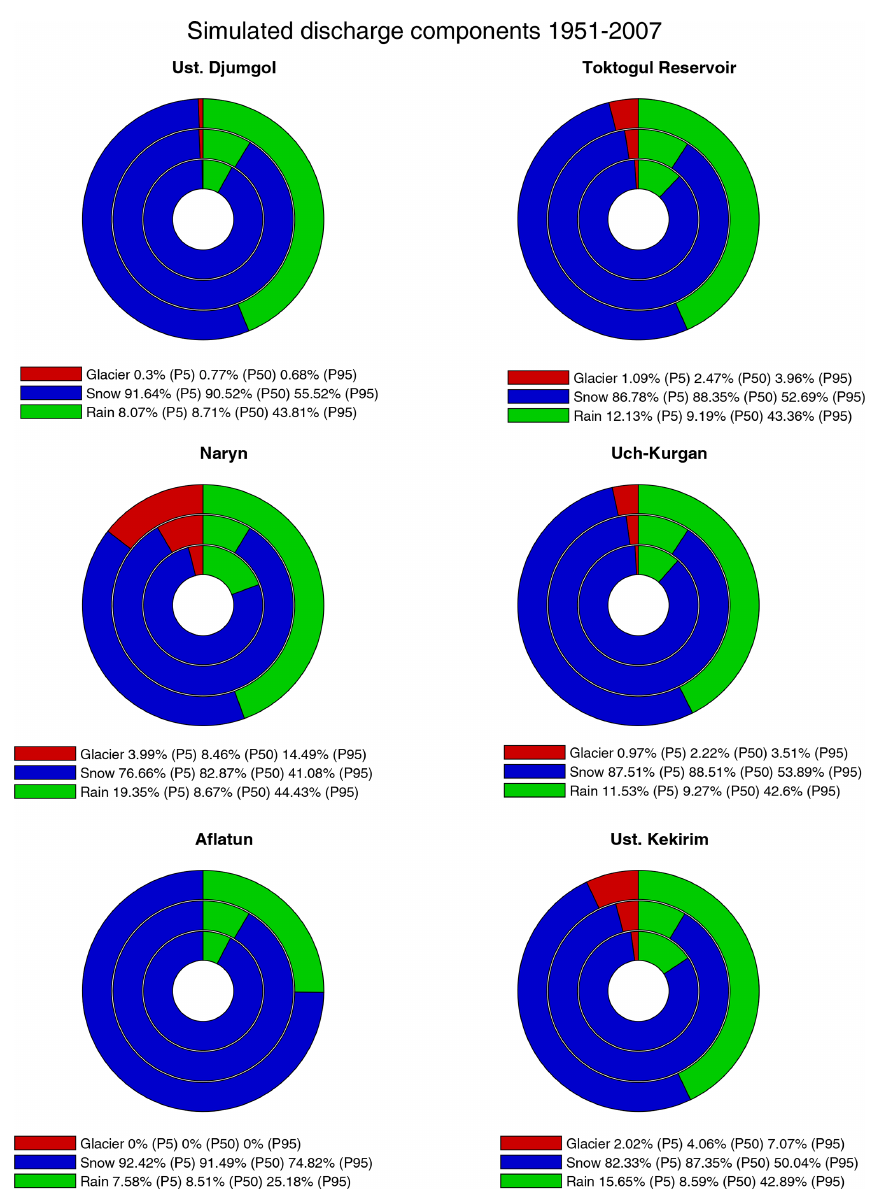
Figure 10. Simulated fraction of annual runoff from snow melting, glacier melting and rain averaged for the years 1951–2007. The inner ring shows the 5th percentile, the middle ring is the 50th percentile and the outer ring is the 95th percentile